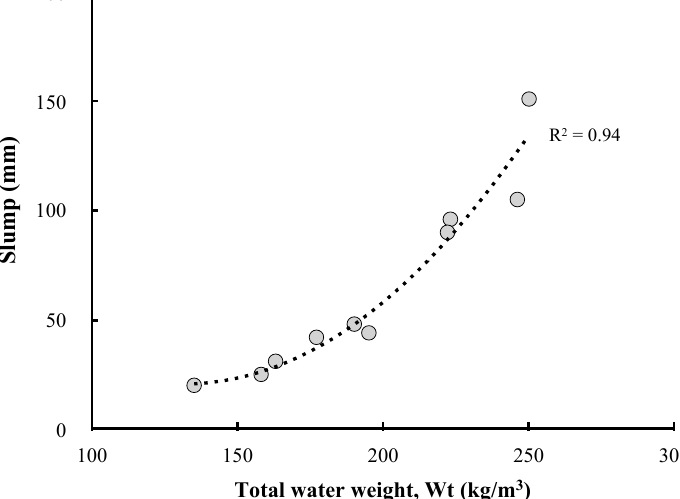
Materials 2020 , 13 , x FOR PEER REVIEW Figure 9. Relationship between slump and total water weight Figure 9. Relationship between slump and total water weight